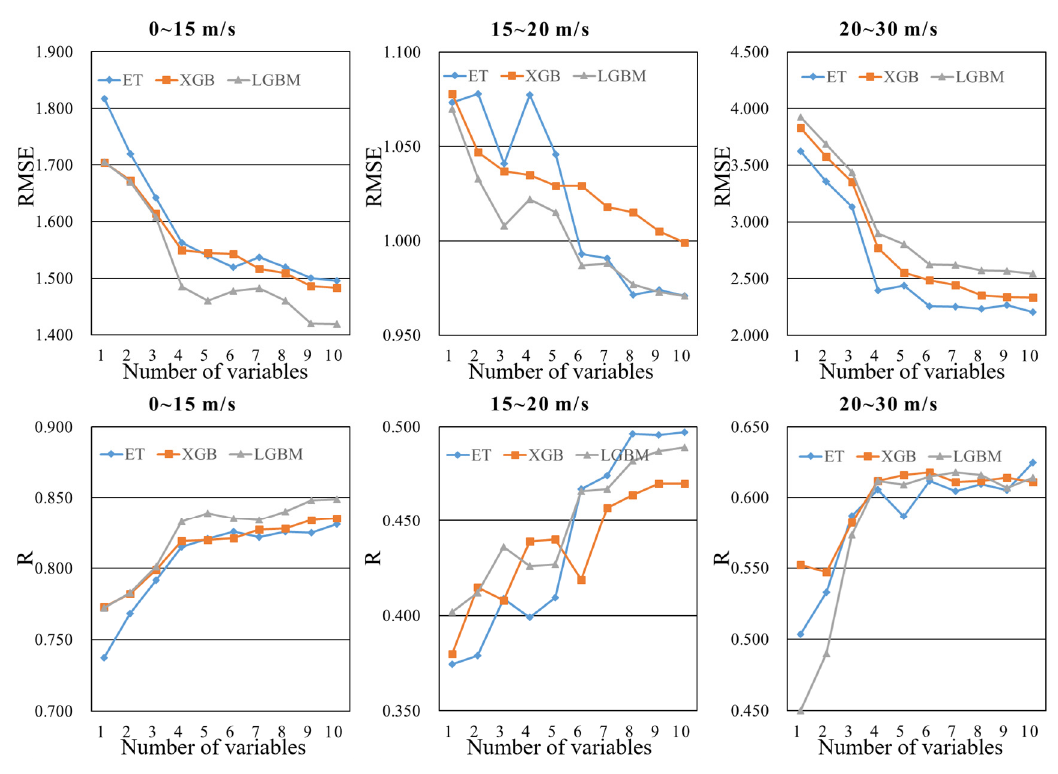
Figure 12. RMSEs and Rs of the wind speed retrieval models using different numbers of variables.